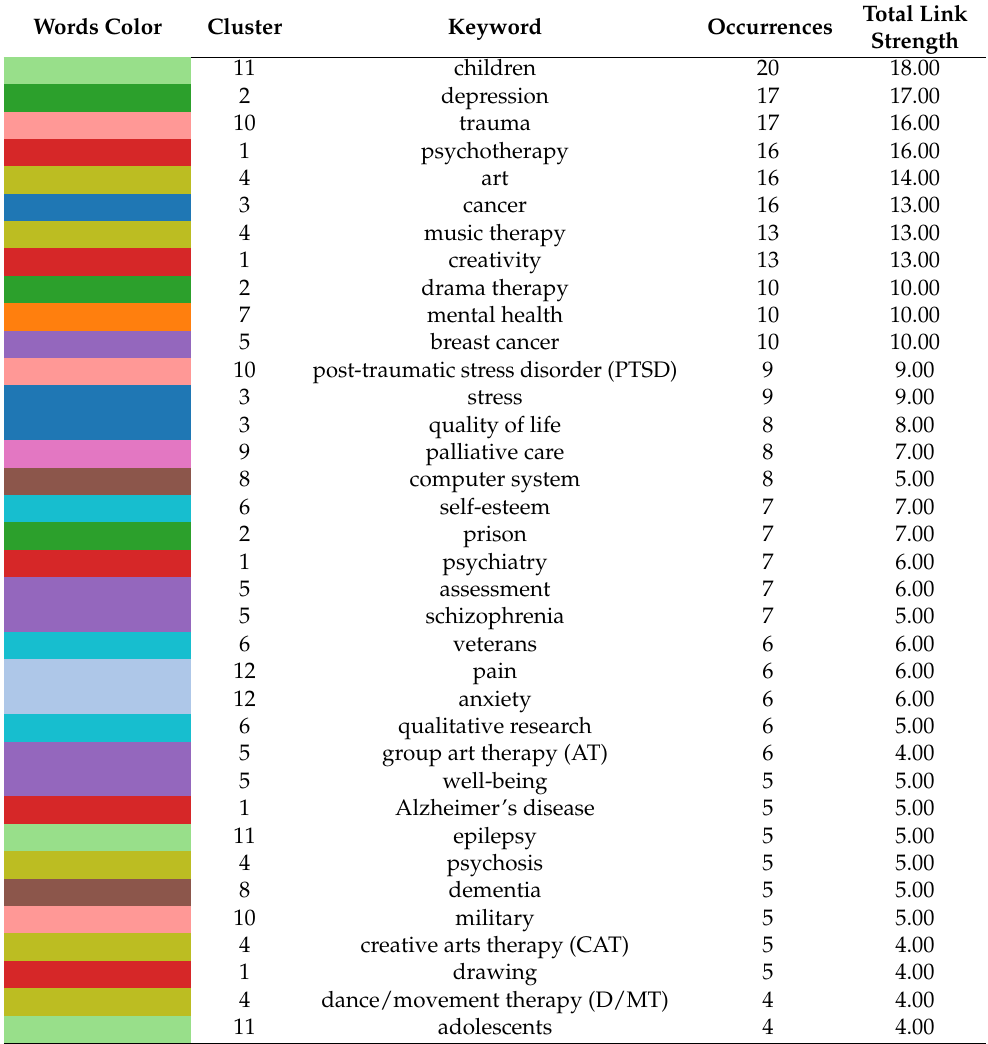
Table 1. High-frequency keywords of art therapy (AT)-aided health and well-being study from year 1946 to September 2021 via network visualization of VOSviewer (devised by the authors).